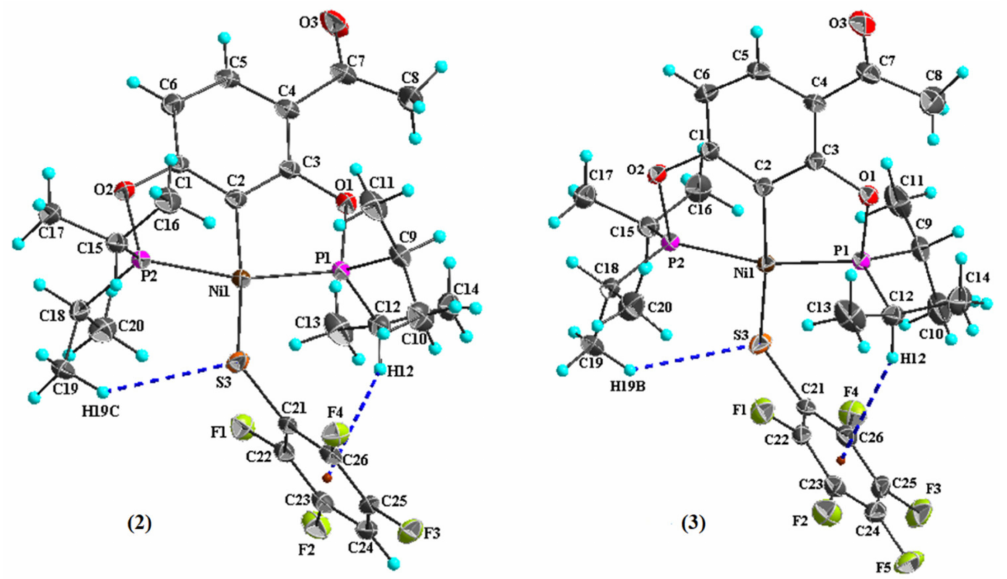
Figure 1. The molecular structure of compounds ( 2 ) and ( 3 ), showing the atom labelling schemes. Displacement ellipsoids are drawn at 40% probability level. The intramolecular interactions are drawing as dashed